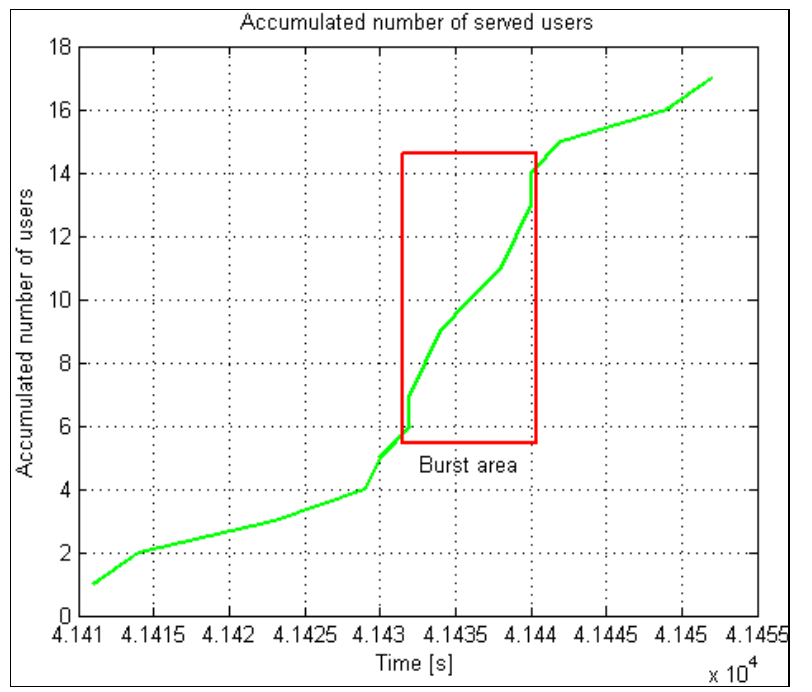
Figure 19. A burst in the random pattern on the accumulated number of users characteristic. P = 15, U = 17.